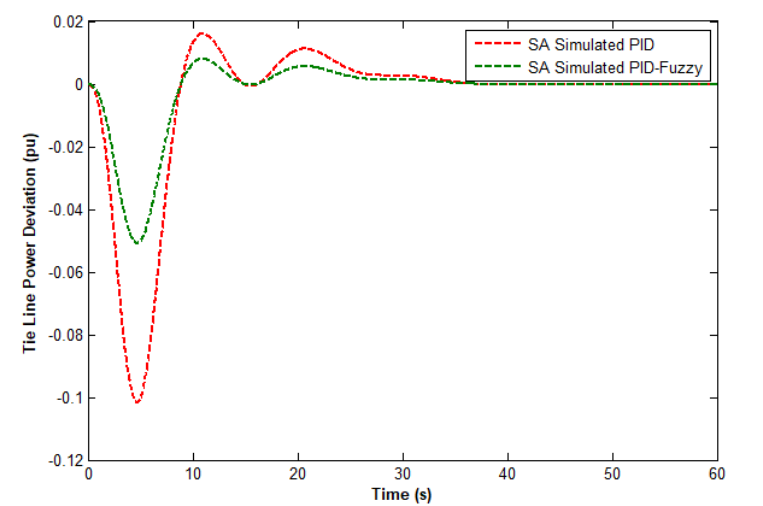
Figure 9. Tie-line power deviations for the first